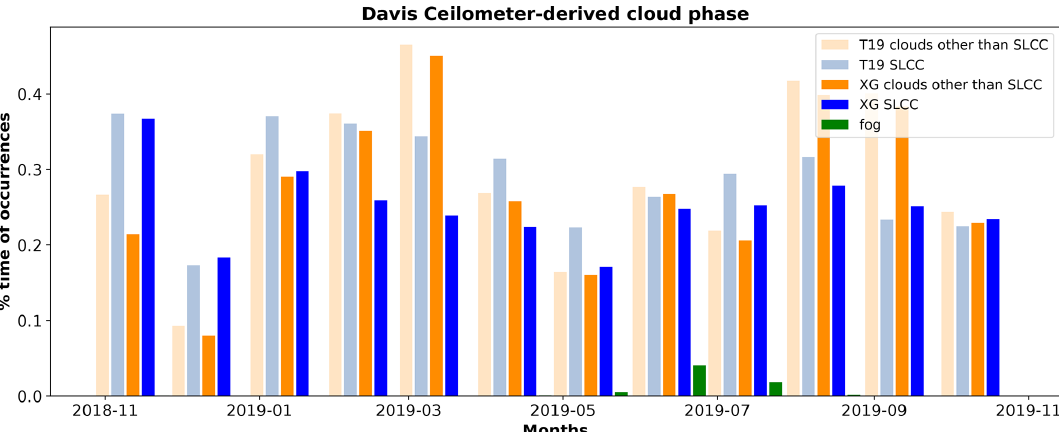
Figure 10. Cloud phase occurrences (SLCC or clouds other than SLCC) as retrieved using T19 or G22-Davis. Fog occurrences are also